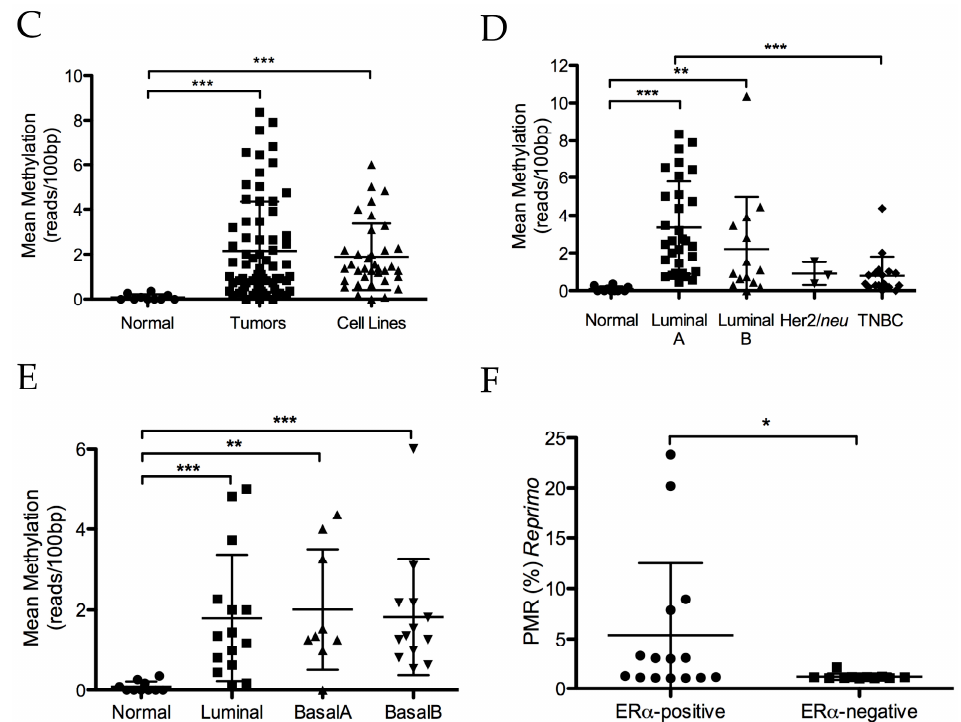
Figure 1. DNA methylation of promoter CpG-island (CGIs) region in breast cancer. Methyl-CpG binding domain (MBD-seq) was used to generate DNA methylation profiles of normal breast tissue ( n = 10), primary tumors ( n = 77), and cell lines ( n = 38). ( A ) The figure represents methylation intensity by 100-bp resolution. The pre-calculated methylation intensity is shown as a red gradient heatmap. At the top part, in black is shown the gene body with an arrow that indicates the ATG sequence. In green, the CGIs of the gene is shown. The solid line highlights the region analyzed (1.1 kb; chr2: 154042600–154043700); ( B ) the Green box represent CGIs amplified from Figure 1A, where we observe a higher mean methylation of CGIs for each 100-bp resolution (calculated as the mean methylation for each 100-bp) in primary tumors and cell lines respect to normal breast tissue; ( C ) methylation intensity (calculated as the mean methylation intensity of CGIs—1.1 kb—for each case) was significantly higher in primary tumors and cell lines compared to normal breast tissue ( p < 0.0001); ( D ) a scatter plot among different molecular subtypes in primary tumors showed significant differences in the average value of methylation in the Reprimo ( RPRM ) CGIs region for Luminal A compared to normal breast tissue and also for triple negative breast cancer (TNBC); ( E ) a scatter plot among different molecular subtypes in breast cancer (BC) cell lines showed significant differences compared to normal breast tissue, but not among them; ( F ) scatter plot of the validation cohort (26 breast cancer samples) showing the significant differences in percentage-methylated relative (PMR) of RPRM CGIs between breast cancer estrogen receptor α (ER α )-positive and ER α -negative. TNBC, triple